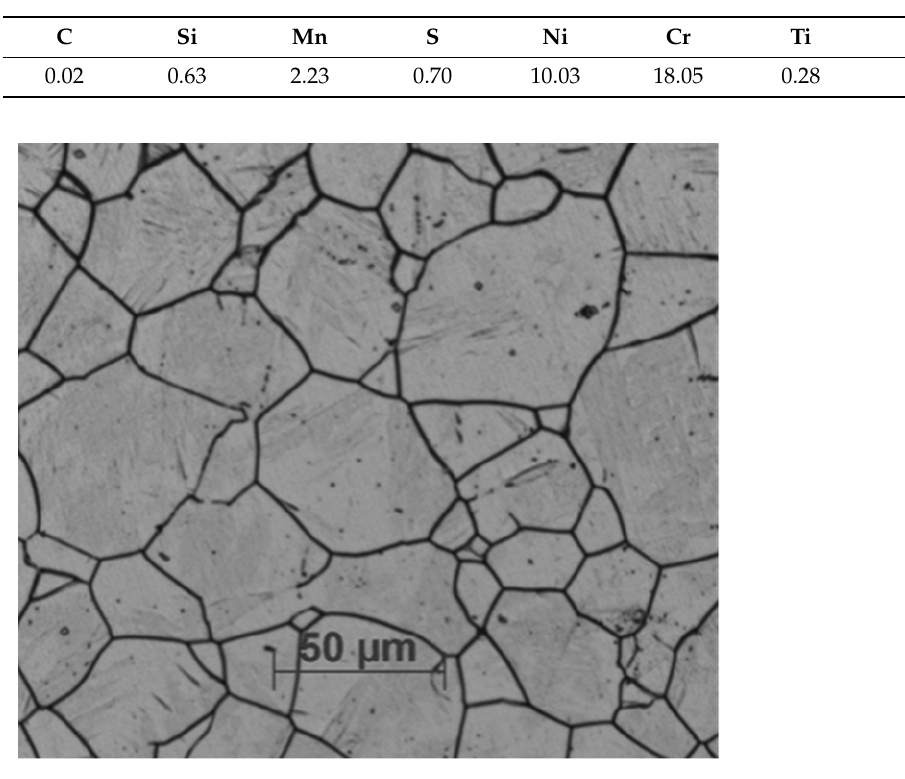
Table 1. Chemical composition of 321 stainless steel (wt %).